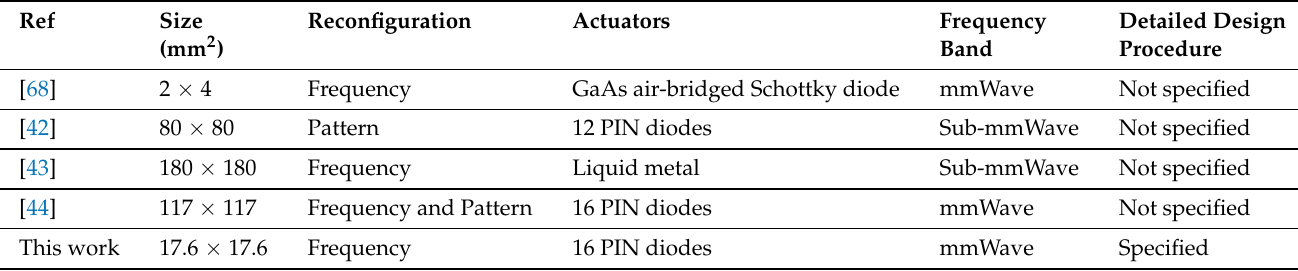
Table 5. Comparisons between proposed 16 elements frequency RMS and existing